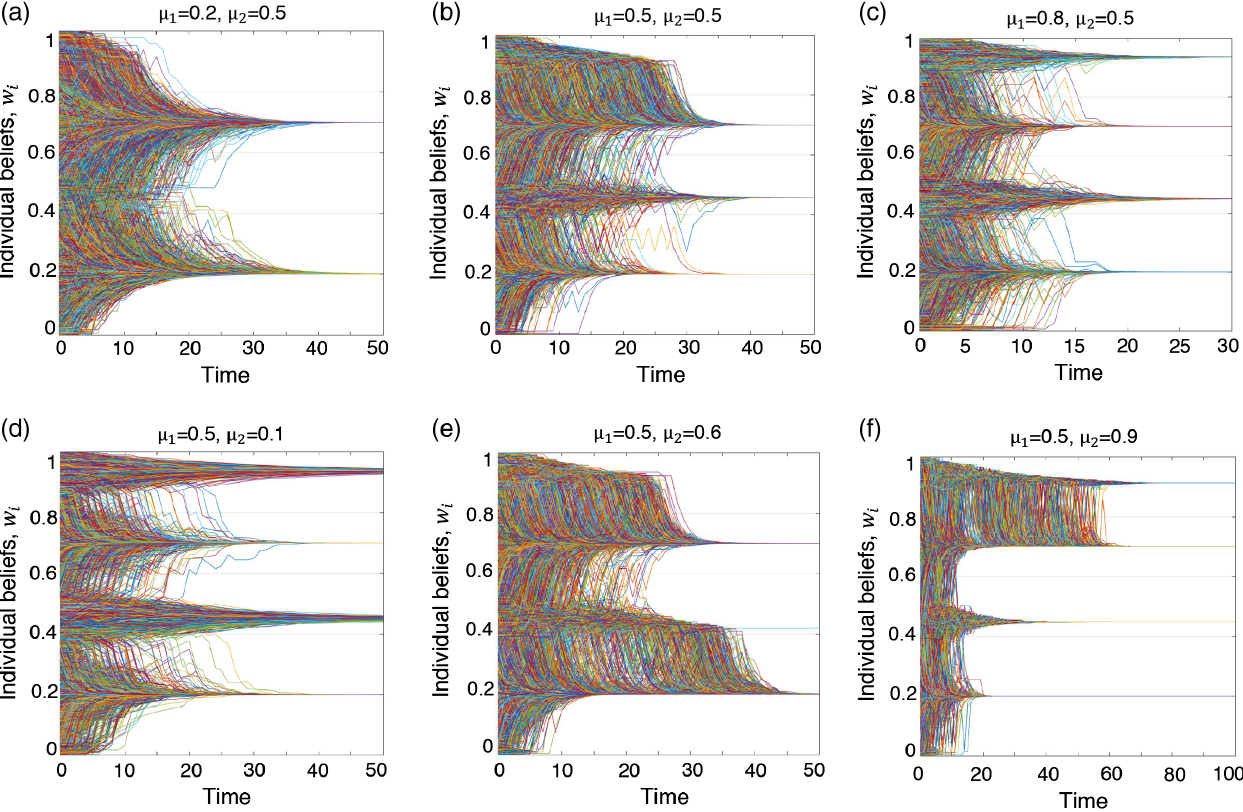
FIG. 4. Evolution of individual beliefs under different degrees of confirmation bias. (a) – (c) Strong positive feedback between candidates and voters accelerates the opinion polarizing process and leads to insufficient social discourse where more undecided individuals exist. (d) – (f) Intermediate levels of discussion partner influence increase interactions between individuals of different beliefs, which reduces the undecided people and effectively prevents the formation of small clusters of extremists. Parameters: All simulations begin from an ER graph with N ¼ 10 4 , h k i ¼ 6 , Ω T ¼ 0 . 5 , θ 1 ¼ 0 . 2 , θ 2 ¼ 0 . 7 , and δ 1 ¼ 0 . 18